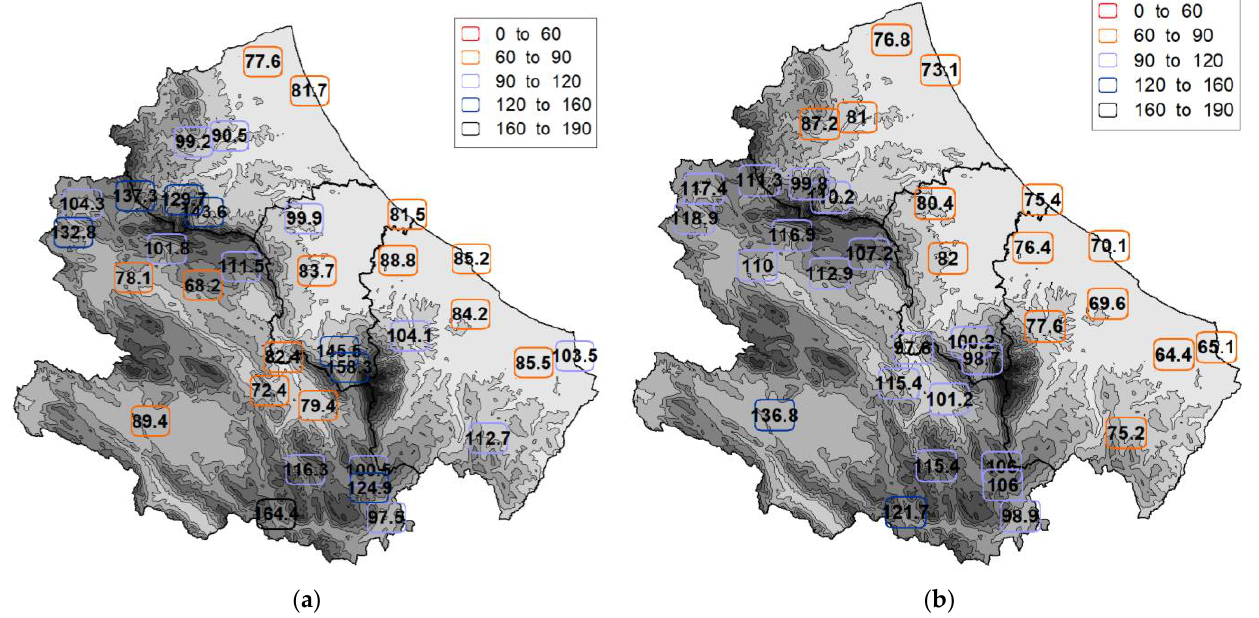
Figure 4. Spatial distribution of median values of MFI: ( a ) point data; ( b ) E-OBS data.